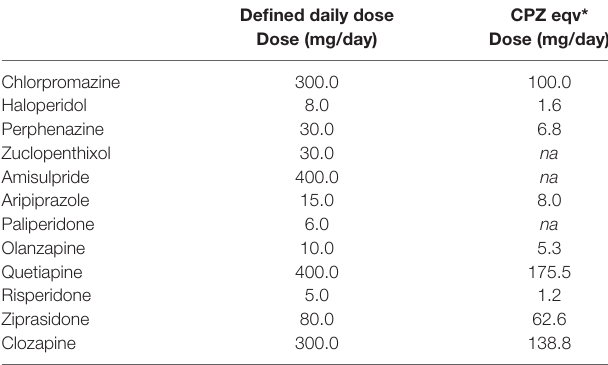
TABLE 1 | Prescribed antipsychotics and comparison of defined daily dose and chlorpromazine